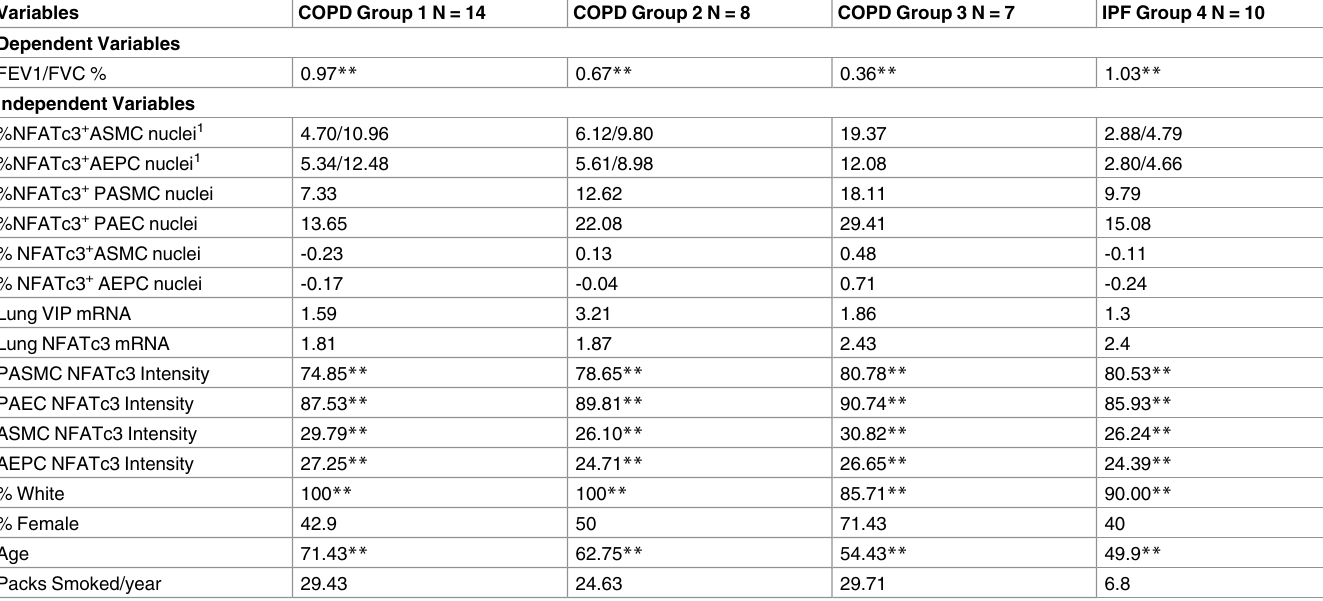
Table 1. Means and Frequencies of FEV1/FVC % and Key Explanatory Variables By